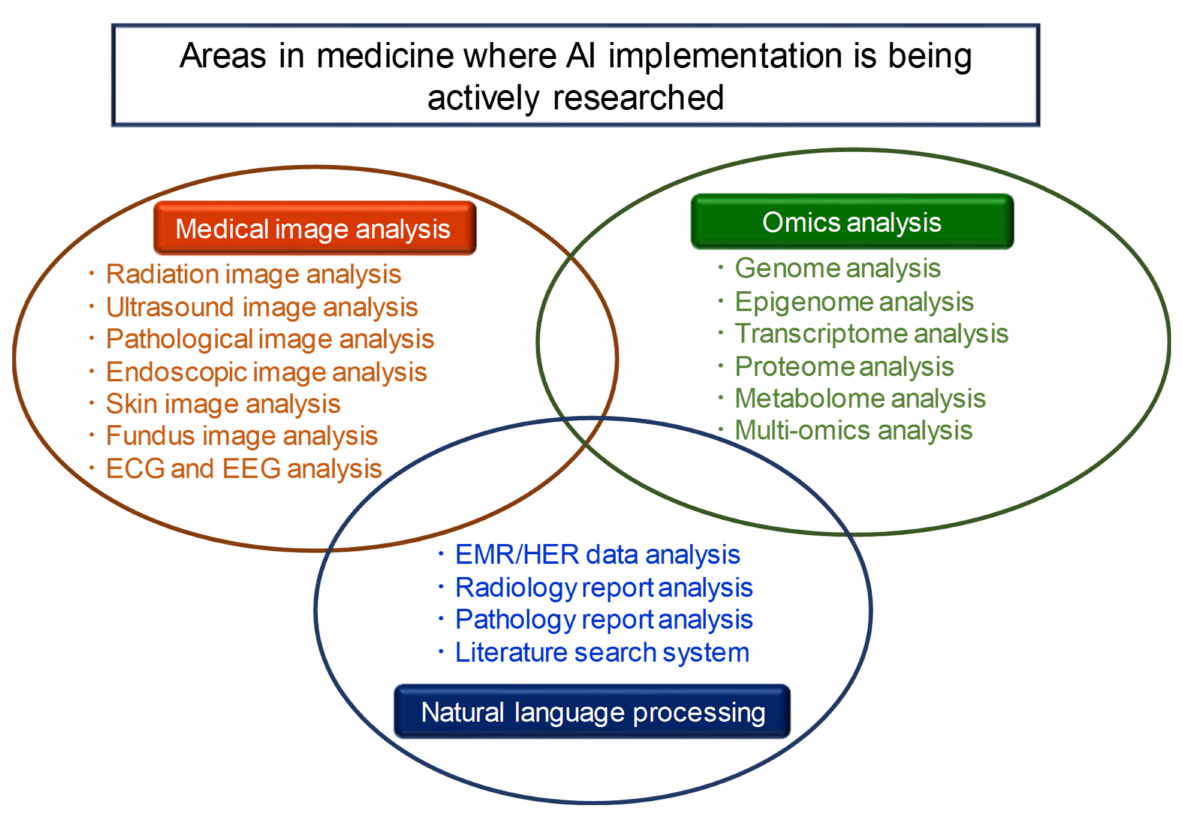
Figure 1. There are three areas in which AI technology is currently being actively implemented in the medical field: medical image analysis, omics analysis, and natural language